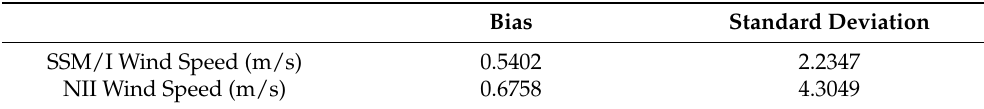
Figure 2. Scatter plots of the NII, FNL, and SSM/I paired data. ( a ) Scatter plots of the FNL and NII wind speed. ( b ) Scatter plots of the FNL and SSM/I wind speed. The dashed line in this figure is the diagonal line. Table 2. NII, SSM/I, and FNL sea surface wind velocity data statistical analysis.